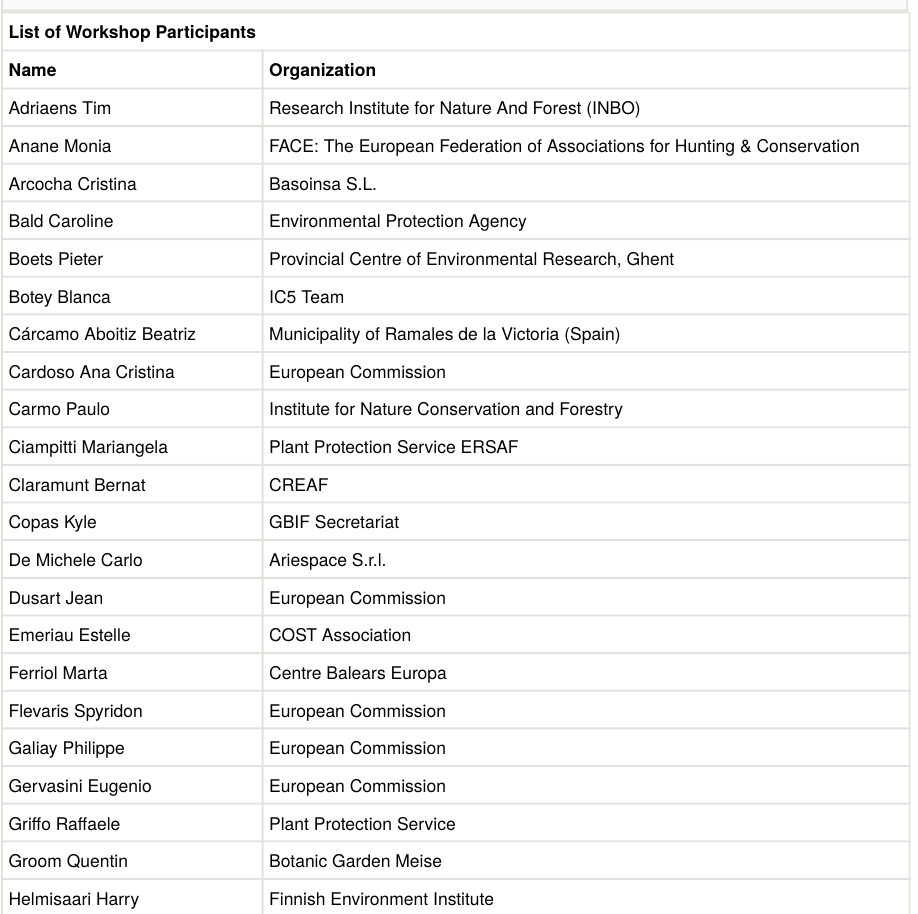
List of Workshop